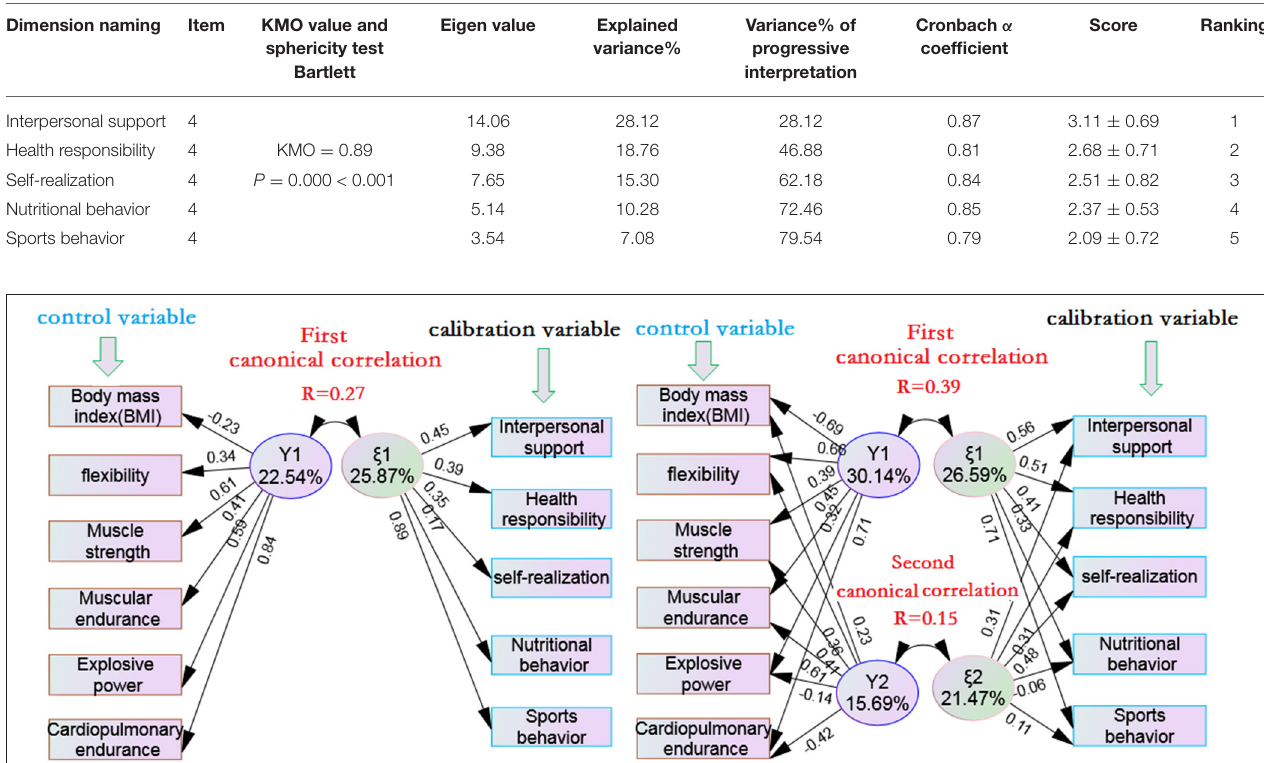
TABLE 2 | Validity and reliability of the health-promoting lifestyle scale.